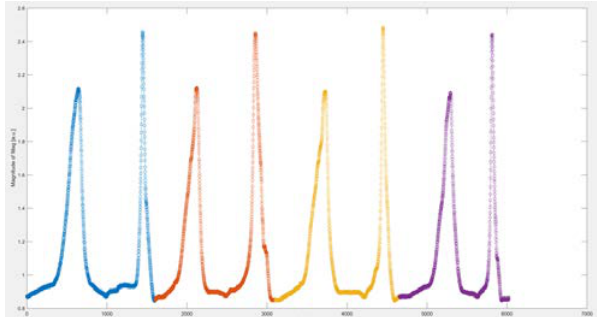
Figure 5: Magnitude of the measured magnetic signal when looping the same path four times.